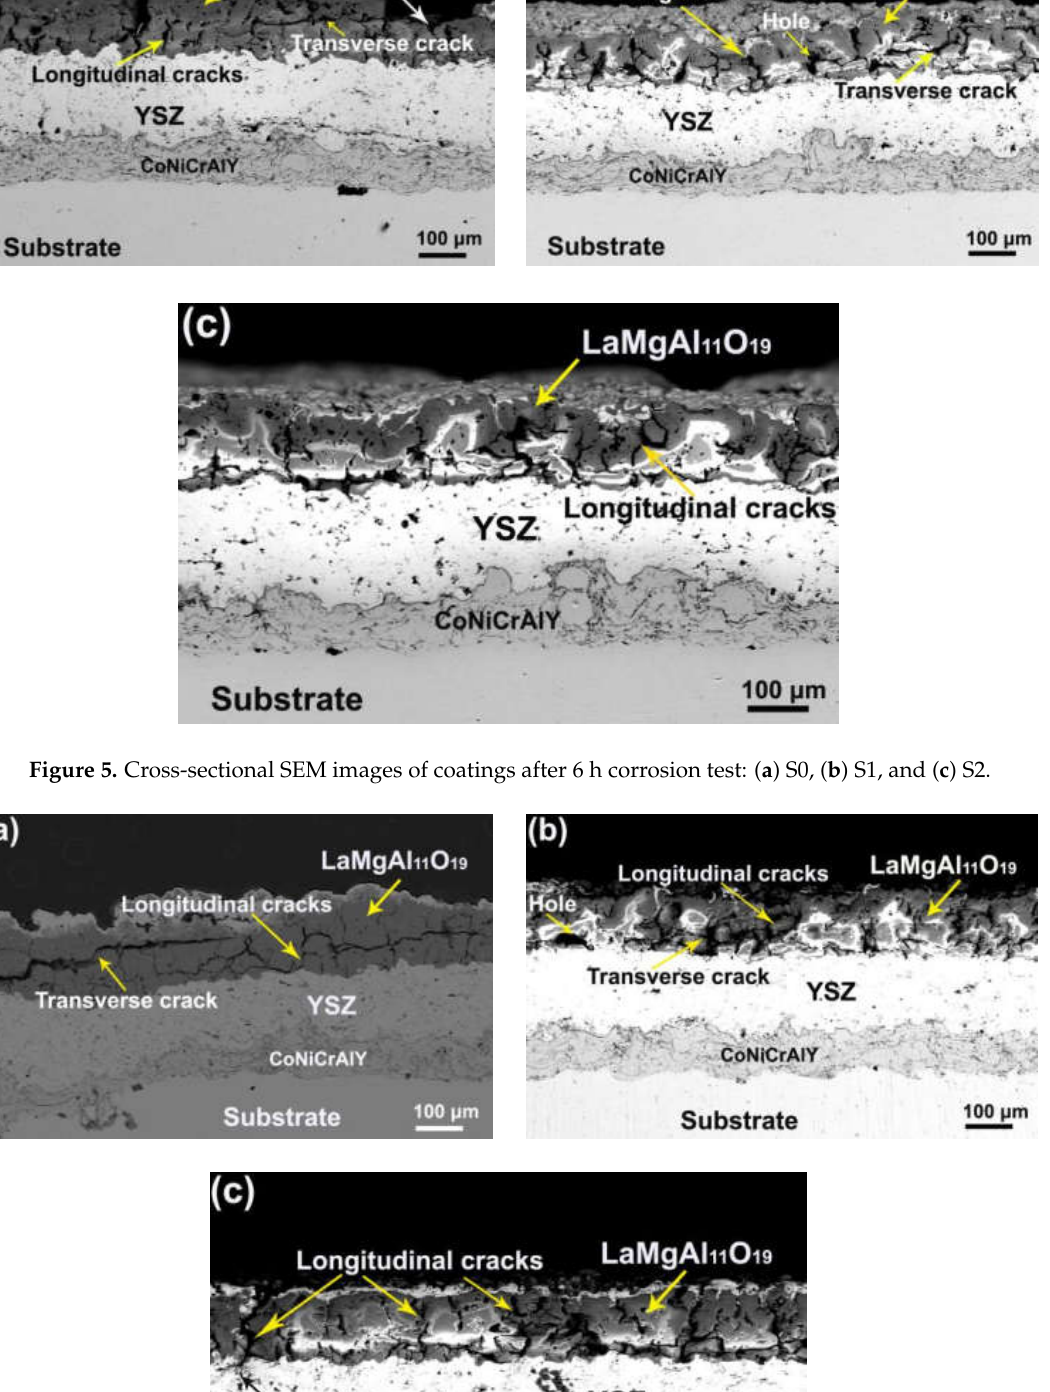
Figure 5. Cross-sectional SEM images of coatings after 6 h corrosion test: ( a ) S0, ( b ) S1, and ( c ) S2.